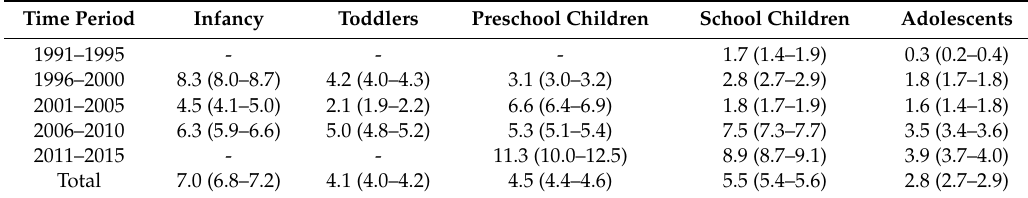
Table 3. Subgroup analysis by development stage of the prevalence of obesity in Chinese children and adolescents aged 0–18 years (%).